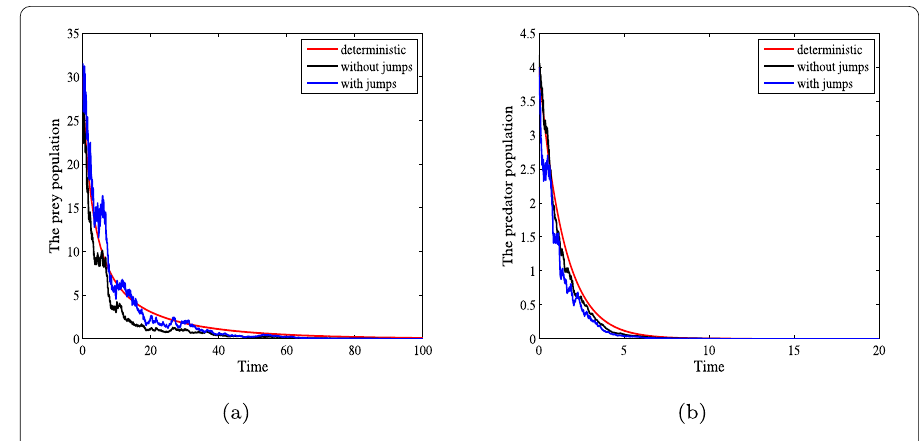
Figure 4 Deterministic and stochastic trajectories of prey population and predator population with b = 0.02, d 1 = 0.04, α = 0.01, A 1 = 3, σ 2 1 = 0.3, σ 2 2 = 0.2, γ 1 ( u ) = γ 2 ( u ) = 0.1 and other parameters are taken as in Table 1. ( a ) Trajectories of prey population. ( b ) Trajectories of predator population. (Color figure